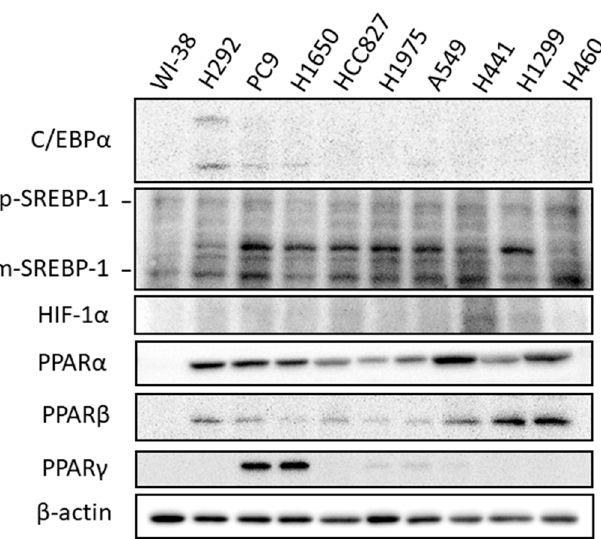
Figure 2. The expressions of transcriptional regulators involved in regulation of lipogenesis and lipid storage in lung cancer cells. The expressions of these transcriptional factors were compared between nine lung cancer cell lines and the normal lung cell line, WI-38, and measured using immunoblot analyses when cell growth reached about 80% confluence. The input cell lysates were adjusted into an approximately equal β -actin signal intensity and were used as a basis to compare target protein expressions on the same blot.